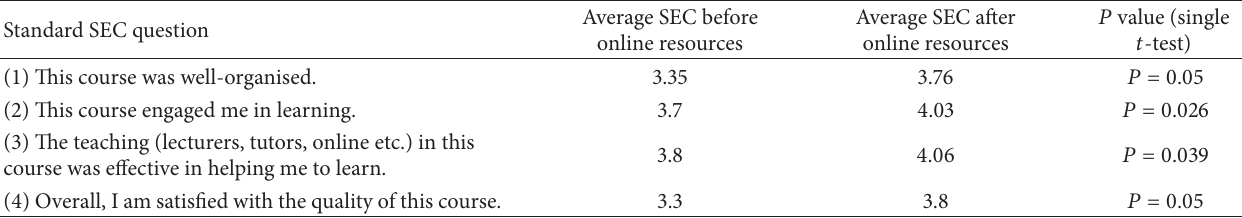
Table 3: Showing a summary of the SEC standard questions’ results obtained over the period of the study before and after the introduction of the 2D online resources ( 𝑃 < 0.05 was used to establish significance).